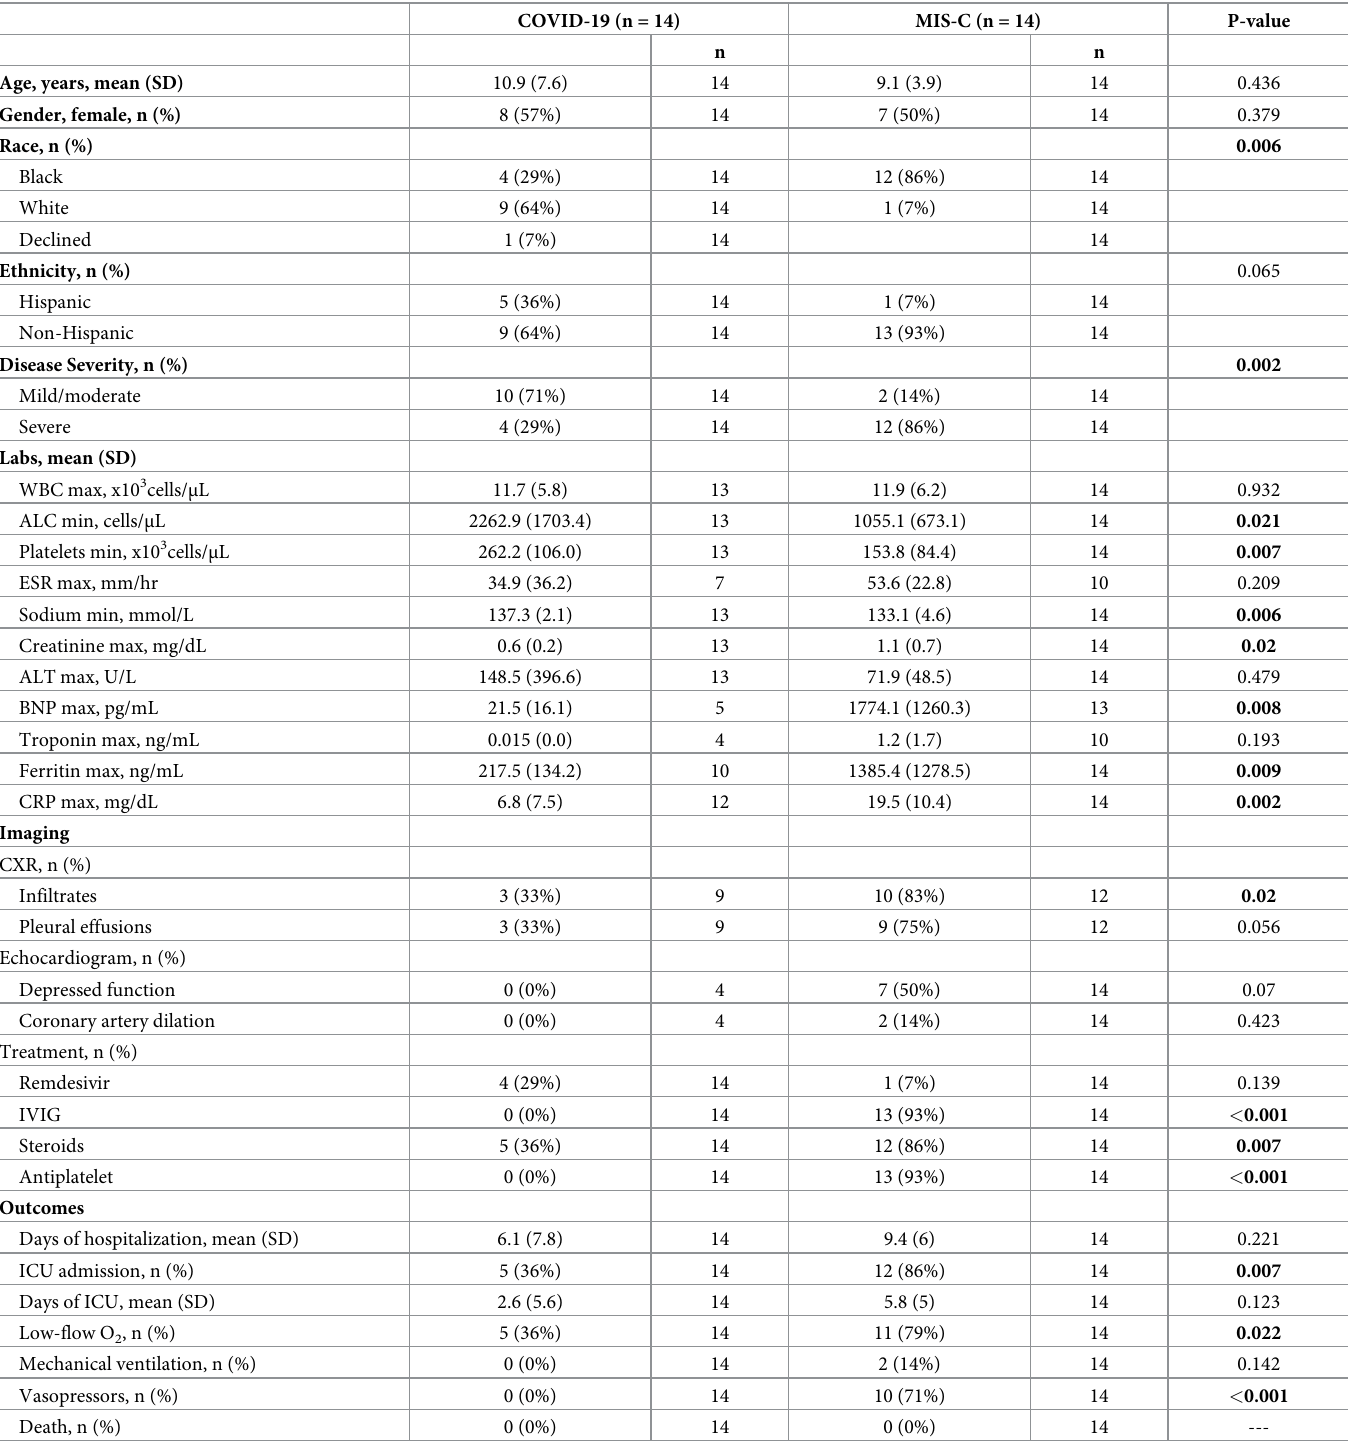
Table 1. Clinical and demographic characteristics of patient cohort of children hospitalized with acute COVID-19 or MIS-C at Children’s Healthcare of